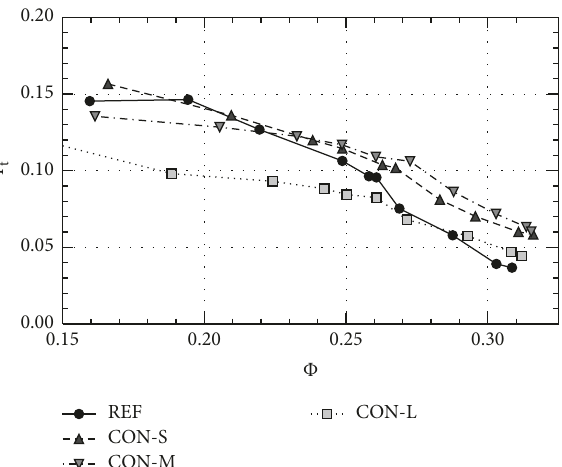
Figure 17: Influence of different conical shroud extensions under 𝜇 = 0.245 and 𝛾 = 90 ∘